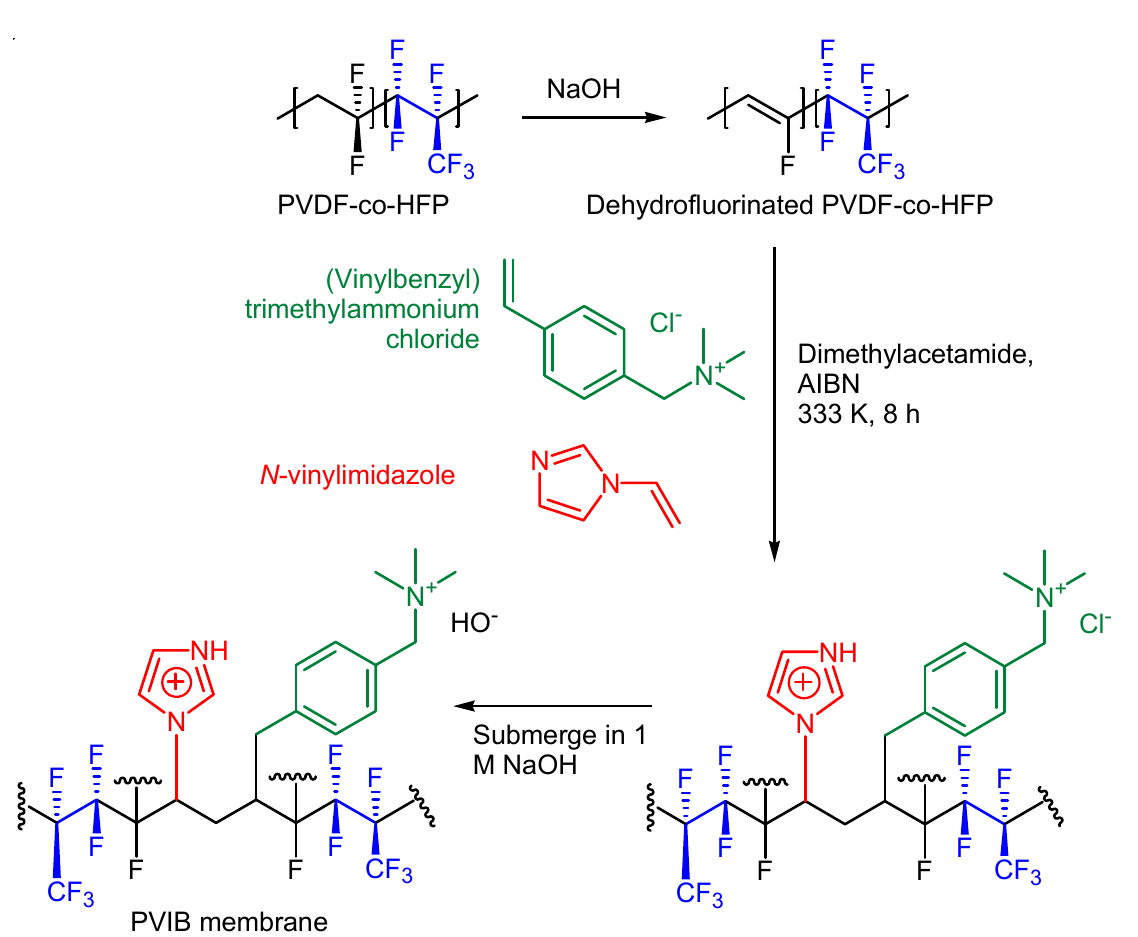
Figure 2. Synthesis and structure of the PVIB-based polymer.